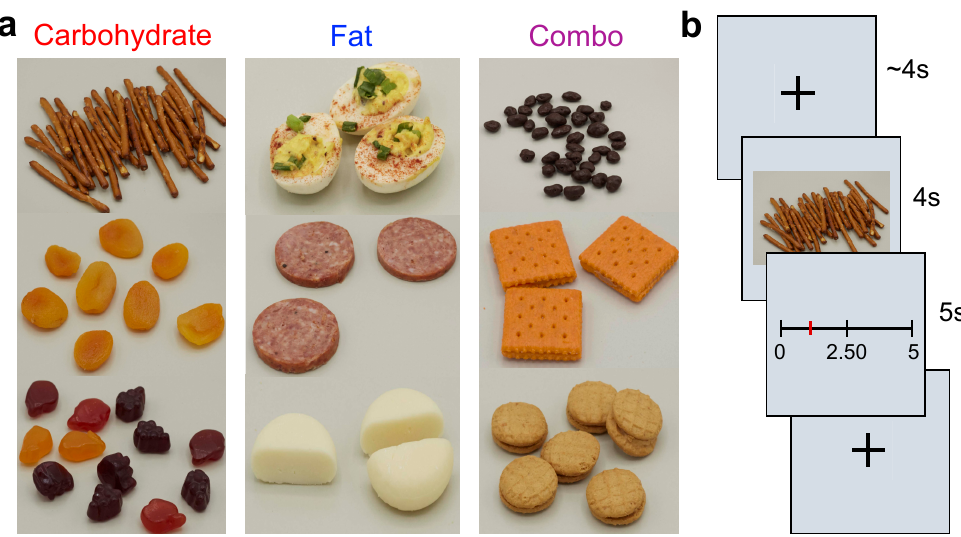
Figure 1. Study design. ( a ) Example MacroPics food pictures in the three macronutrient categories: carbohydrate, fat, and combo. ( b ) Sample trial from the auction task in which participants viewed a fixation cross, observed a food image, and bid for the snack from 0–5 USD.